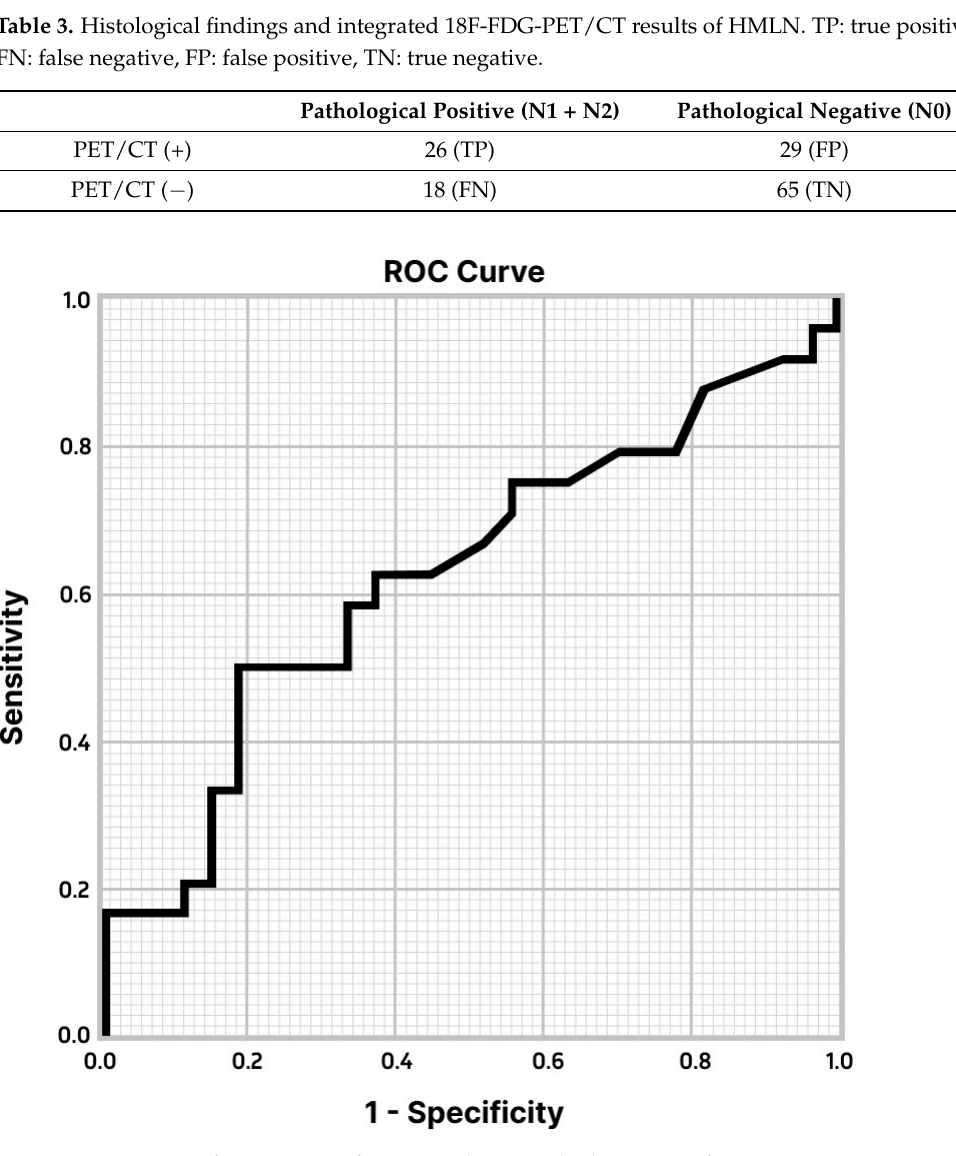
Figure 3. ROC curve for SUVmax of HMLN. The curve had an AUC of 0.625 (95% CI 0.468–0.782) with a cut-off SUVmax 4.7. 3.3. Risk Factors Associated with False Negative Detection of HMLN Metastasis of 18F-FDG- PET/CT Staging The incidence of occult HMLN metastasis in this study was 21.7% (18/83). Of 18 pa- tients with lymph node metastasis, multi-station metastasis was found in 4 patients, while the other 14 patients showed metastasis on a single station. Table S1 summarizes the pre- operative 18F-FDG-PET/CT scanning and the patterns of HMLN involvement. Thirteen of eighteen patients had metastasis in the hilar lymph node. Three patients had concurrent diabetes although they had normal levels of fasting blood glucose before the PET/CT scan. Four patients had concurrent lung disease. All 18 patients did not show any pathological FDG uptake in HMLN in integrated 18F-FDG-PET/CT. Table 4 summarizes the results of univariate analysis for factors associated with HMLN metastasis in 83 18F-FDG-PET/CT negative patients. Factors significantly associ- ated with HMLN metastasis were tumor size (>3.0 cm, p = 0.008), presence of VPI ( p = 0.020), and SUVmax of tumor ( ≥ 8.25, p = 0.026). The multivariate analysis (Table 5)